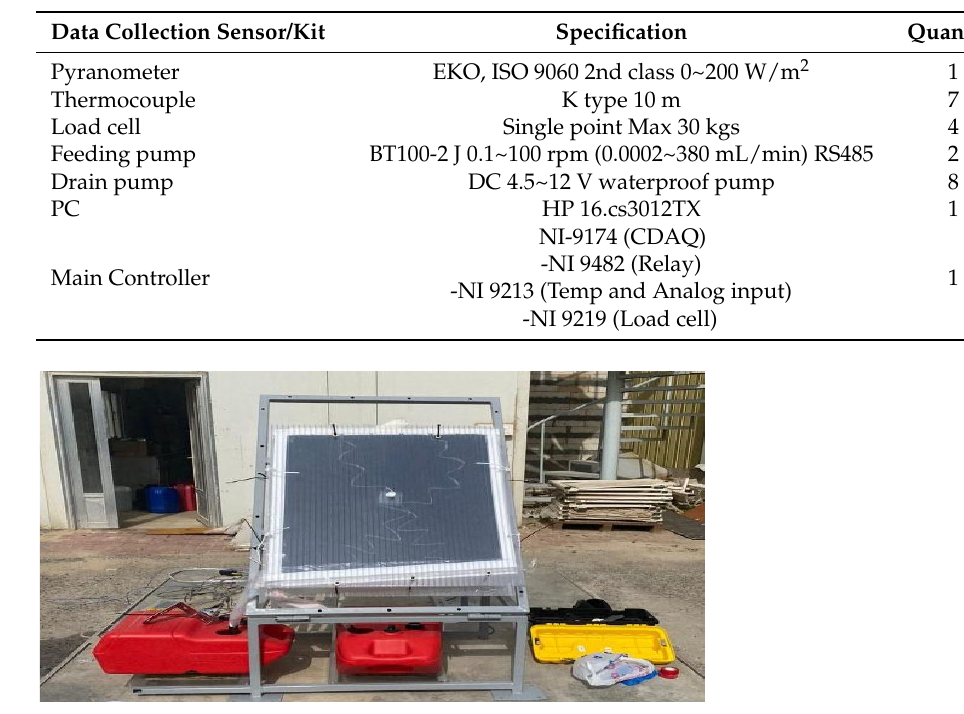
Figure 8. fully installed MSS unit with 20 ‐ L waste containers. Figure 8. Fully installed MSS unit with 20-L waste